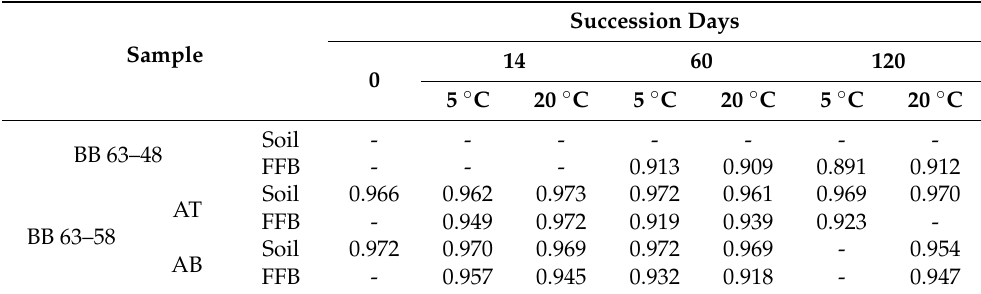
Table 3. The Simpson Index calculated based on the number of sequences along the course of succession in the studied samples of Antarctic soils.